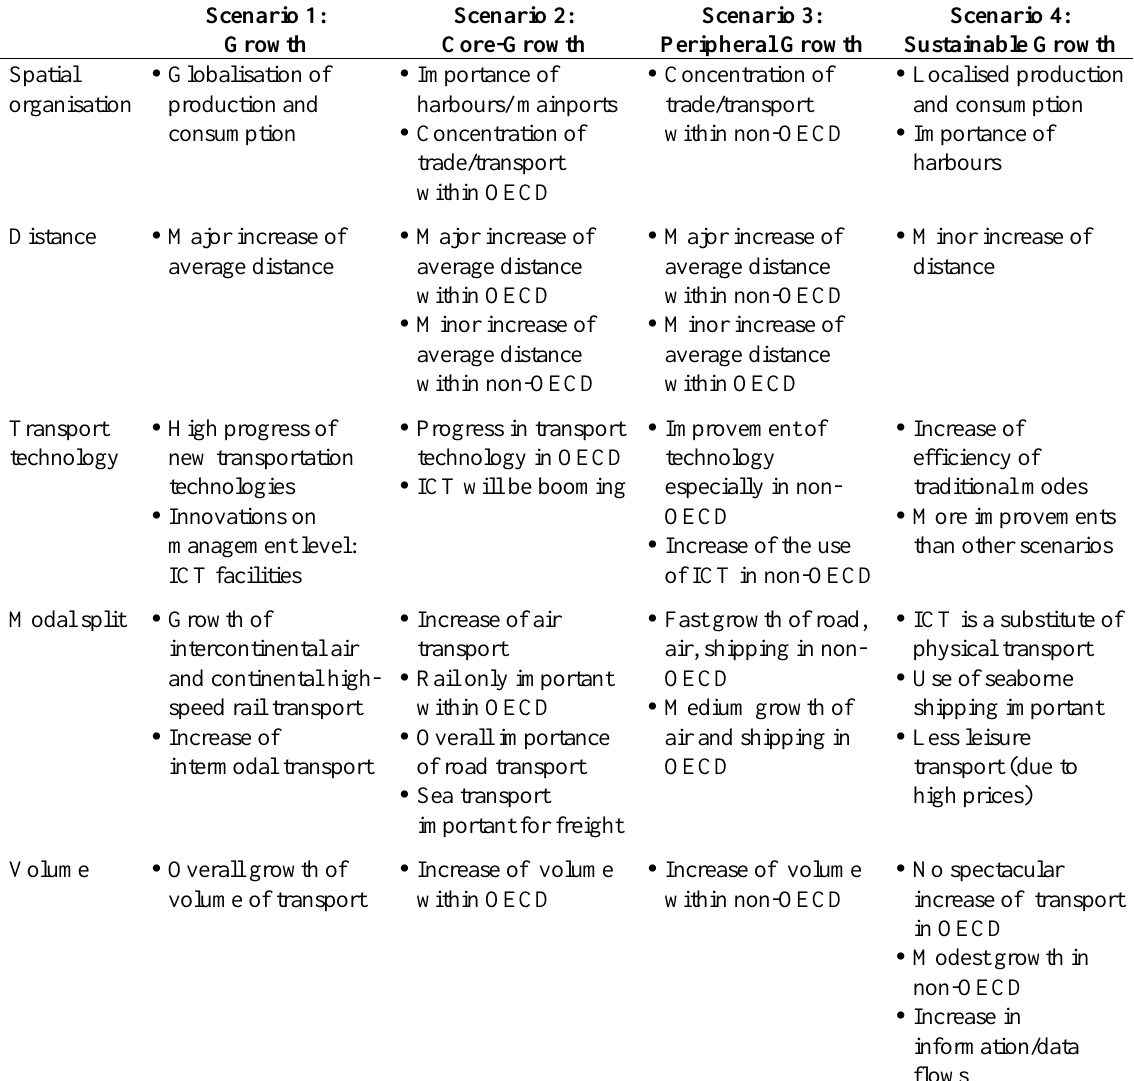
Table 5. Synthesis of